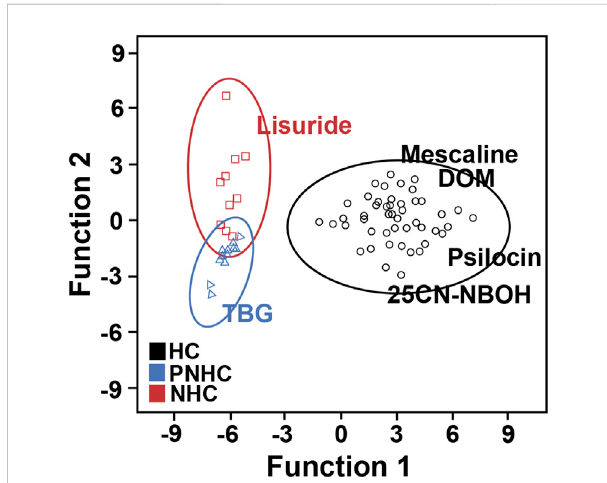
FIGURE 7 Graphical representation of the results from discriminant function analysis of all behavioural parameters. HC, hallucinogens; PNHC, putative nonhallucinogens; NHC, nonhallucinogens.